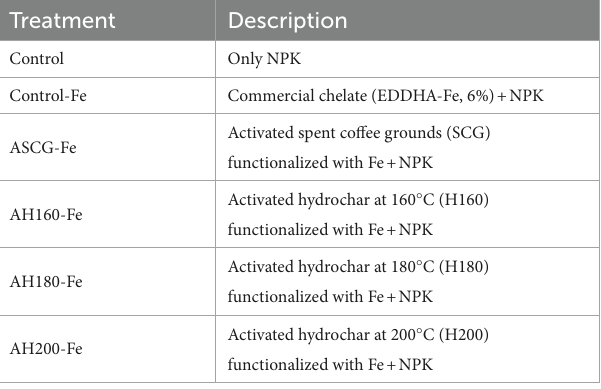
TABLE 1 Summary and description of